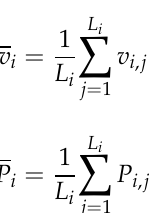
Figure 2. Scattered relationship between wind speed and output power.